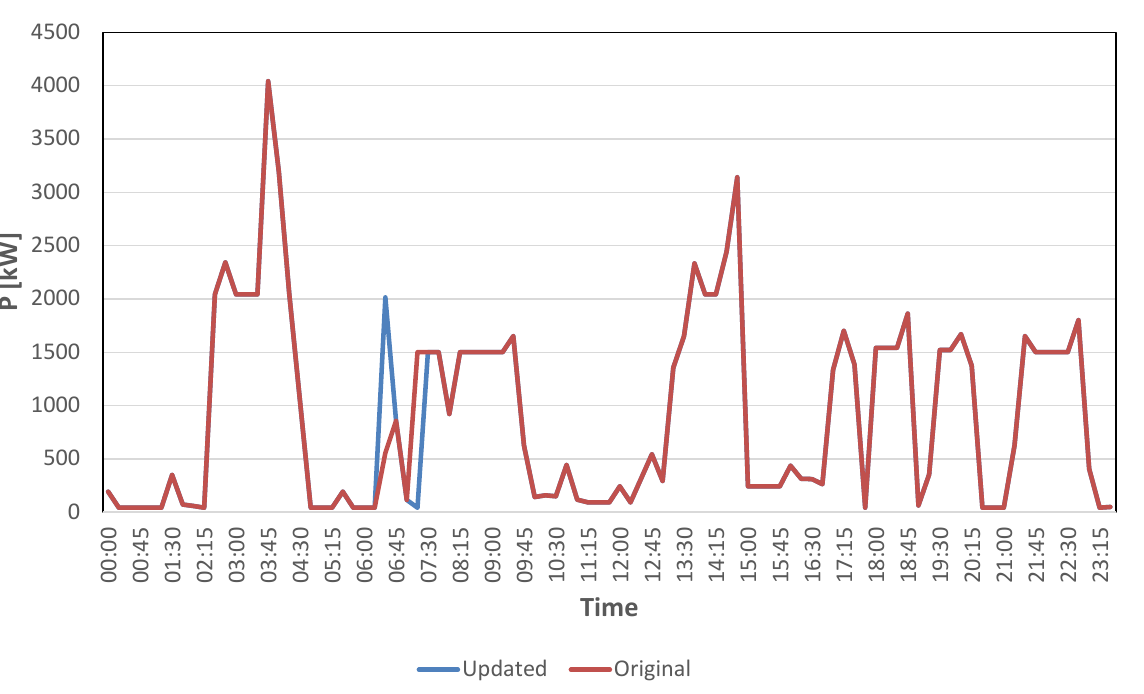
Figure 9. Comparison between the updated and original daily load diagrams after the load shifting action.